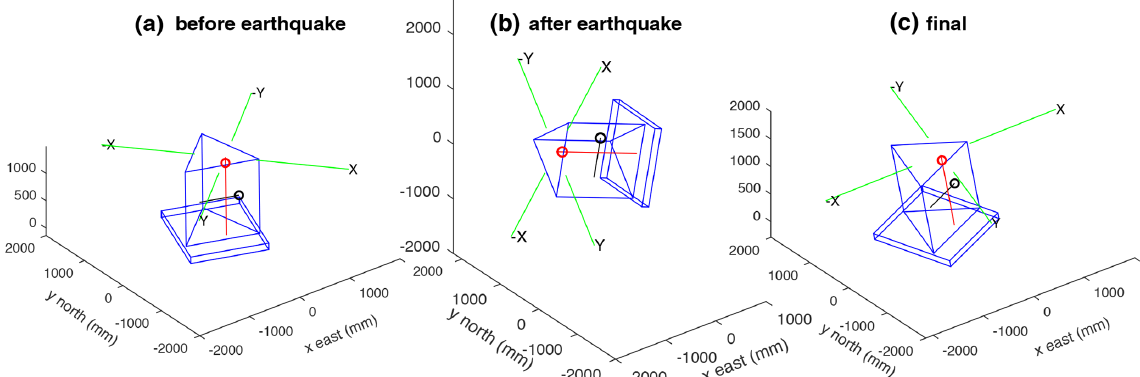
Figure 3. Reconstruction of frame position based on instrument tiltmeter and compass data: (a) before the earthquake; (b) tilted, between 25min and 10.5h after earthquake; and (c) back in nearly upright position 11h after earthquake. Position of Digiquartz pressure sensor (black circle), Aanderaa tide sensor (red circle) and Doppler current meter beam cells (green